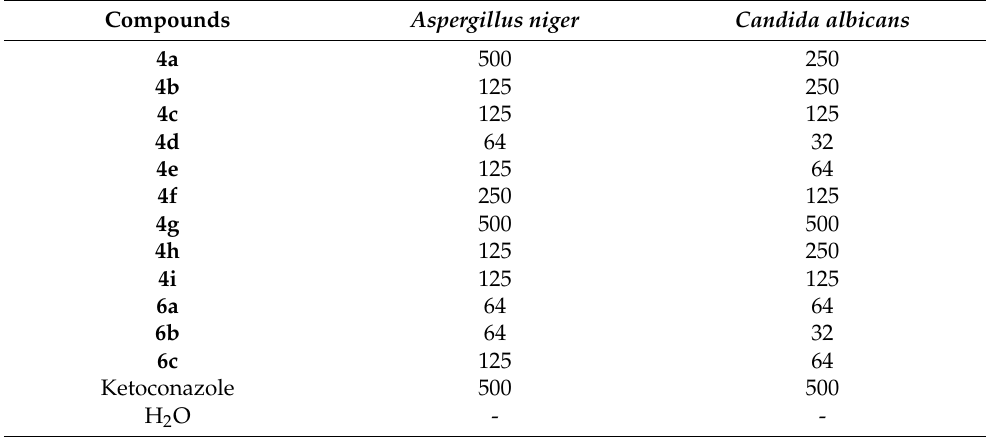
Table 6. Antifungal activities of 2a – c , 4a – i , and 6a – b : minimum inhibitory concentration (MIC).